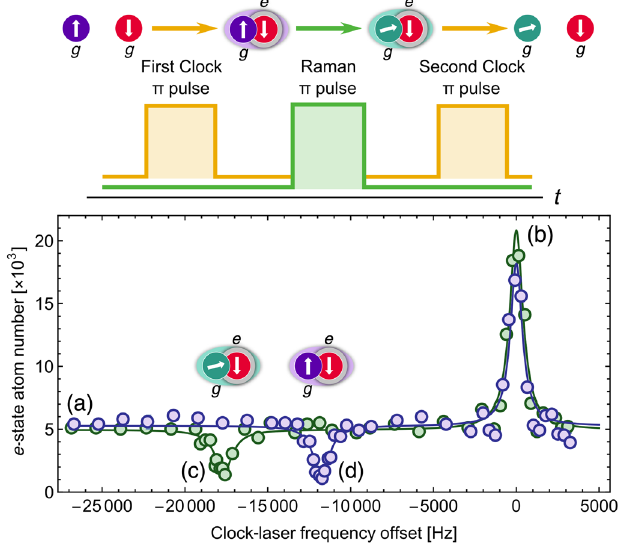
FIG. 7. Clock-laser spectroscopy of a sample with individual atoms and orbital molecules produced with a preliminary clock- laser π pulse. The excitation of individual atoms is detected as an increase in the number of j e i -state atoms (b) with respect to the background (a) and serves a zero-frequency reference. The dissociation of orbital molecules is instead detected as a decrease of j e i -state atoms (c). The blue data correspond to an experiment in which the sample is probed immediately after the production of orbital molecules, while the green data correspond to an experi- ment in which the nuclear-spin state of ground-state component of the molecules has been flipped from þ 5 = 2 to þ 1 = 2 with a bound-to-bound Raman transition (see text for details). The frequency difference between the two dissociation peaks corre- sponds to the energy difference between the bound states of the two different mixtures of spin components at 150 G and a s ¼ 30 lattice depth (see Fig. 2). Both experiments are performed using a sequence of coherent π pulses, as can be seen by the nearly full depletion of the photodissociation